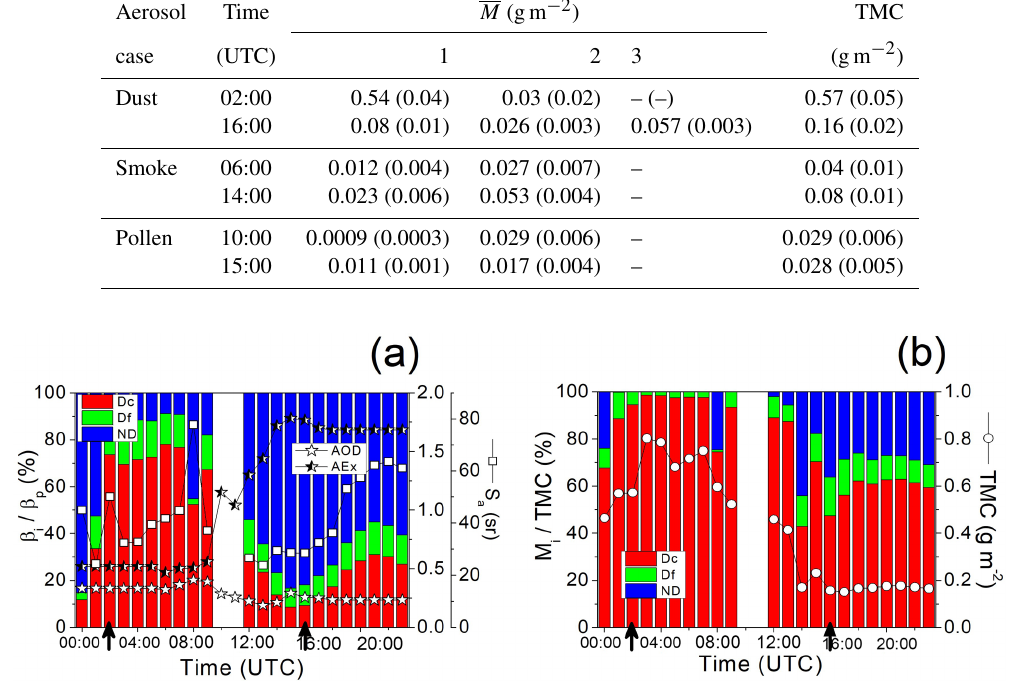
Figure 3. Dust event on 5 July 2016. Evolution of the relative contribution (a) β i (%) and (b) M i / TMC (%) (the bar over the variable are β p removed in the figure for clarity) for each aerosol component throughout the day: Dc (red bars), Df (green bars) and ND (blue bars), which denote dust coarse, dust fine and non-dust aerosols. In (a) (right axis) AERONET hourly averaged AOD and AEx (white and black–white stars, respectively) and KF-derived S a (lidar ratio, sr; square symbols) values are reported; in (b) (right axis) TMC (total mass loading, gm − 2 ; open circles) is also included. Black arrows on the time axis indicate selected times for those vertical profiles shown in Fig. 4.